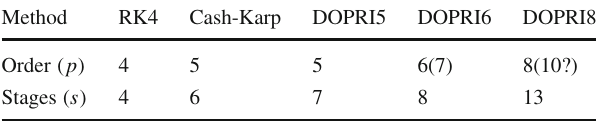
Table4 OrderandnumberofstagesofthedifferentRunge–Kuttameth- ods investigated in this work. The entries in parentheses are explained in the text Method RK4 Cash-Karp DOPRI5 DOPRI6 DOPRI8 Order ( p ) 4 5 5 6(7) 8(10?) Stages ( s ) 4